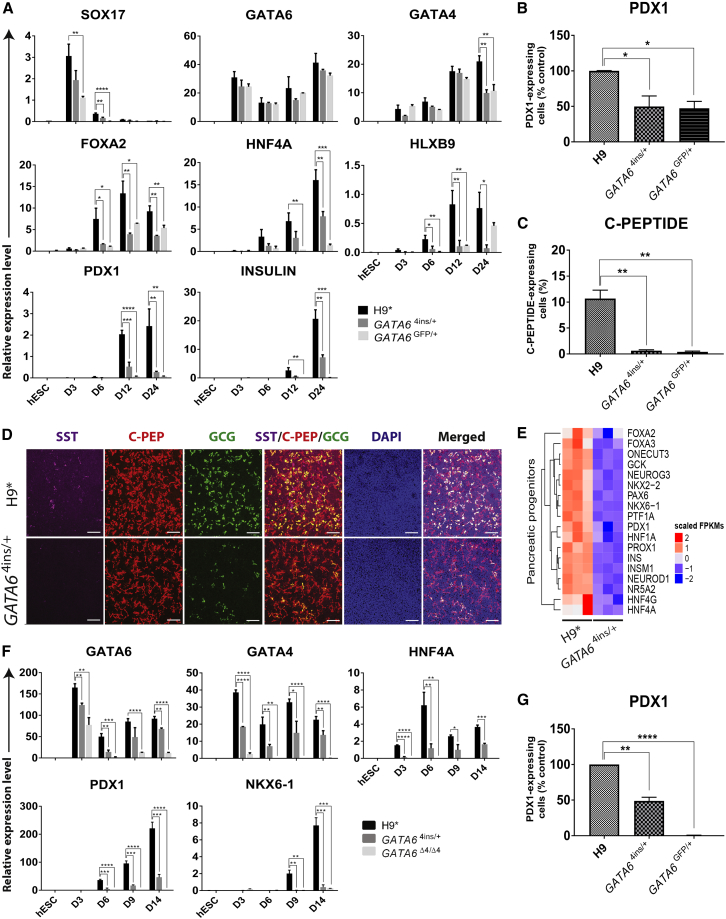
Decreased Levels of GATA6 at the DE Stage Influence Downstream Pancreatic Differentiation(A) Expression of DE (SOX17, GATA6, GATA4, and FOXA2), pancreatic (HNF4A, HLXB9, and PDX1), and endocrine (INSULIN) marker genes in H9∗ and H9-derived GATA64ins/+ and GATA6Δ4/Δ4 mutant cells at the four key stages of the 24-day pancreatic differentiation protocol (Figure S1A).(B) Percentage of PDX1-positive cells in H9-derived GATA64ins/+ and GATA6GFP/+ lines on day 12 shown relative to H9∗ (100%) as measured by FACS.(C) Percentage of C-PEPTIDE-positive cells in H9∗ and H9-derived GATA64ins/+ and GATA6GFP/+ mutant lines at the EP stage (day 24) as measured by FACS.(D) Immunofluorescence analyses for the key PE markers SOMATOSTATIN (SST), C-PEPTIDE (C-PEP), and GLUCAGON (GCG) in H9∗ and H9-derived GATA64ins/+ cells at the EP stage (day 24). DAPI, 4′,6-diamidino-2-phenylindole dihydrochloride. Scale bars, 100 μm.(E) Heatmap illustrating differential gene expression of key pancreatic progenitor markers via RNA-seq between H9∗cells and H9-derived GATA64ins/+ mutant cells at the PE stage. n = 3 biological replicates for each cell line.(F) Expression of DE (GATA6 and GATA4) and pancreatic (HNF4A, PDX1, and NKX6-1) marker genes in H9∗ and H9-derived GATA64ins/+ and GATA6Δ4/Δ4 mutant cells at key stages of the differentiation protocol using the STEMdiff pancreatic progenitor kit.(G) Percentage of PDX1-positive cells in GATA64ins/+ and GATA6GFP/+ lines on day 12 shown relative to H9∗ (100%) as measured by FACS in cells differentiated using the STEMdiff pancreatic progenitor kit.(A–C, F, and G) Error bars represent the SE of three independent experiments. ∗p < 0.05, ∗∗p < 0.01, ∗∗∗p < 0.001, ∗∗∗∗p < 0.0001.